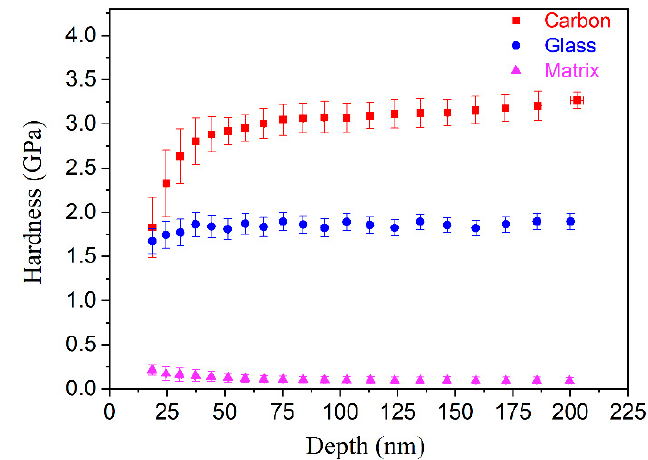
Figure 4. Hardness–depth curves for the three different phases.